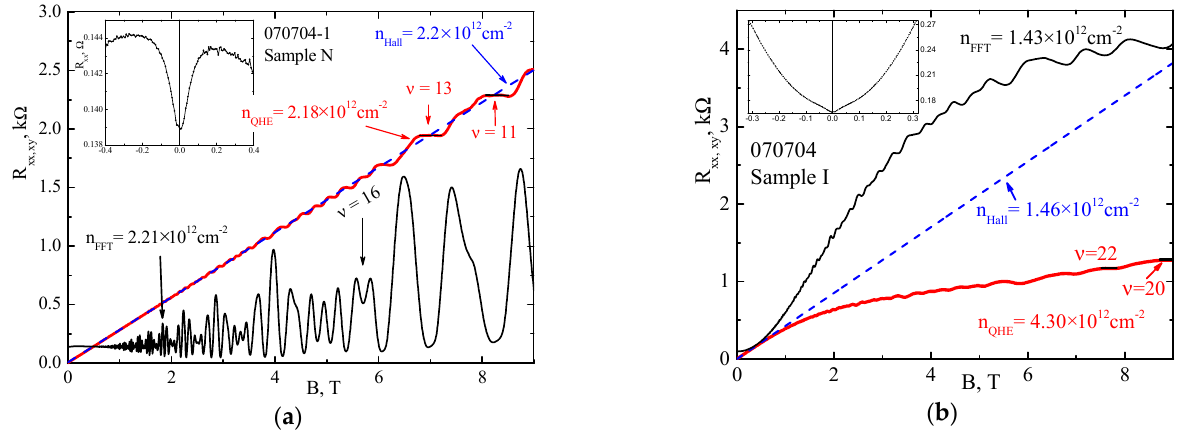
Figure 2. The dependencies of longitudinal, R xx , (black line) and Hall, R xy , (red bold line) resistivities on the magnetic field B at T = 1.8 K for Sample N ( a ) and Sample I ( b ). The QHE plateaus in R xy are marked with the corresponding filling factors ν = 11, 13 for Sample N and ν = 22, 20 for Sample I. Insets in ( a , b ) show the effect of weak antilocalization in both samples.